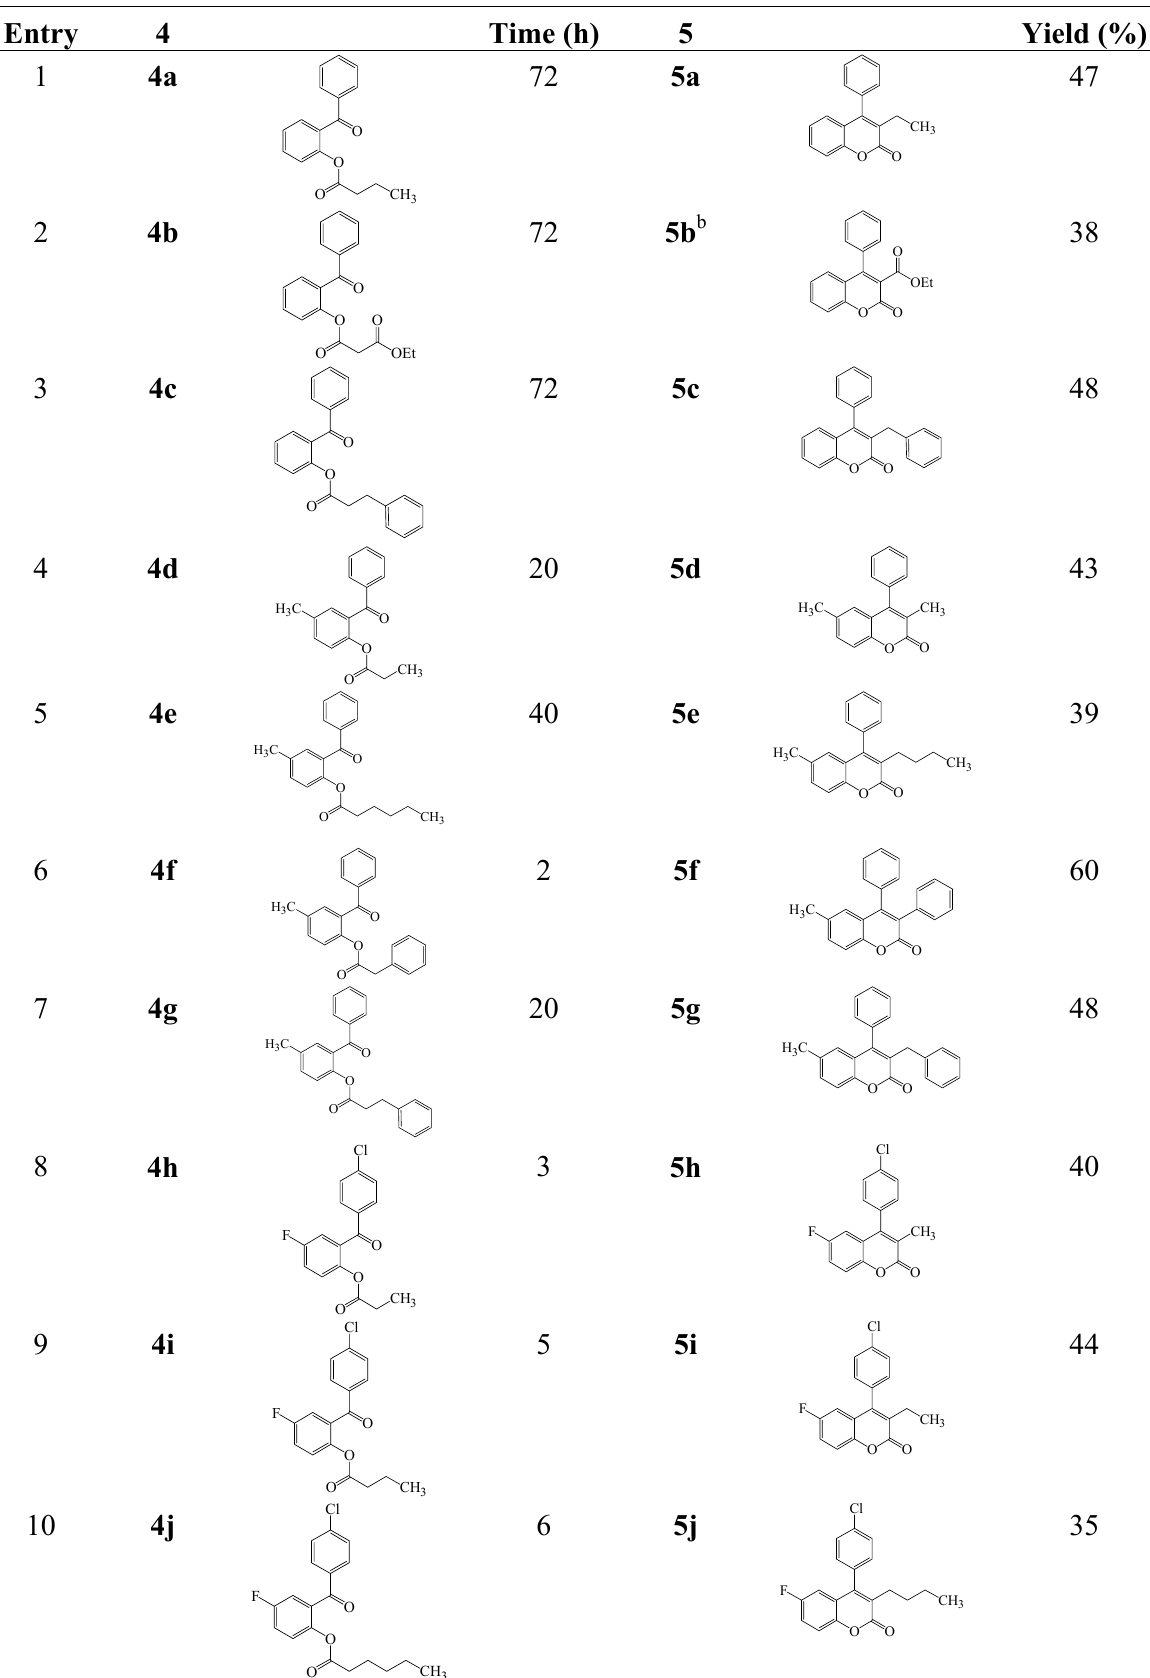
Table 2. DBU-mediated synthesis for 3,4-difunctionalized coumarins a